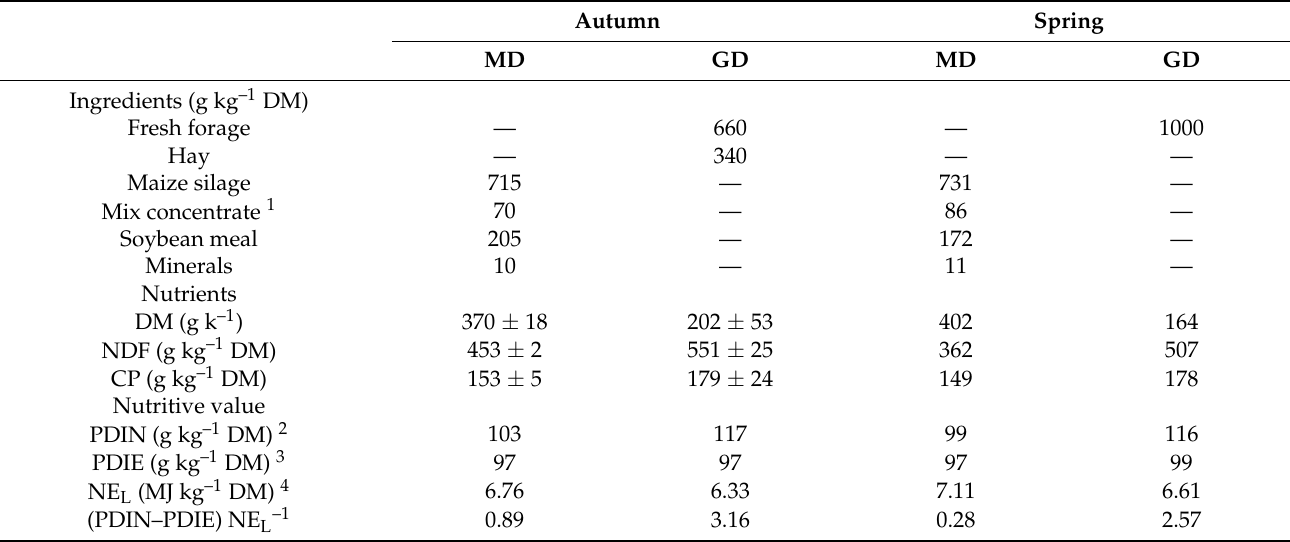
Table 1. Composition of diets (maize-silage-based (MD) or grass-based (GD)) offered to dairy cows housed on a straw-based deep-litter system in autumn and spring. Autumn Spring MD GD MD